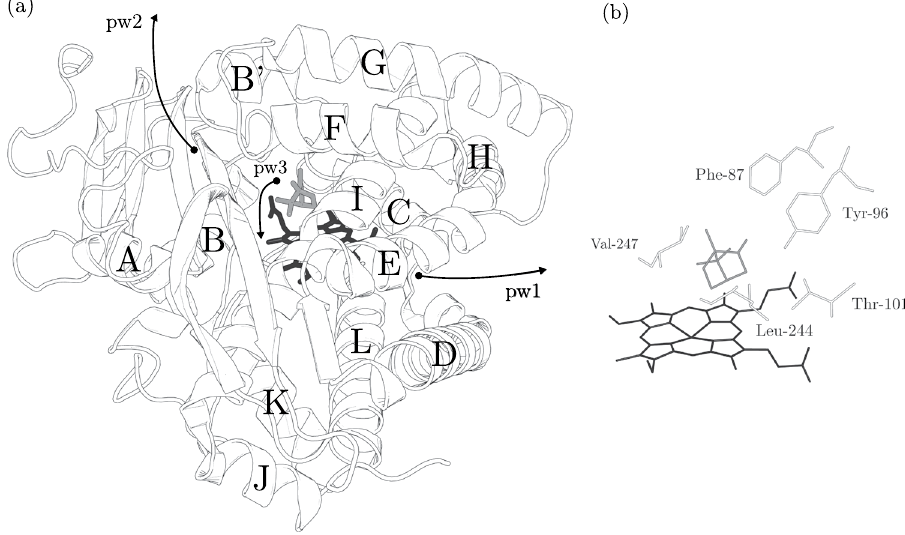
Figure 1. ( a ) Structure of cytochrome P450cam with camphor (gray) and heme (black). Helices are labeled A, B, B ′ and C–L. The diffusion exits of pw1-3 are indicated by arrows. ( b ) The active site with camphor at the crystallographic pose and the aligning residues in the distal heme moiety. For a detailed picture of the camphor diffusion from cytochrome P450cam, see Fig. S1 in the Supplementary